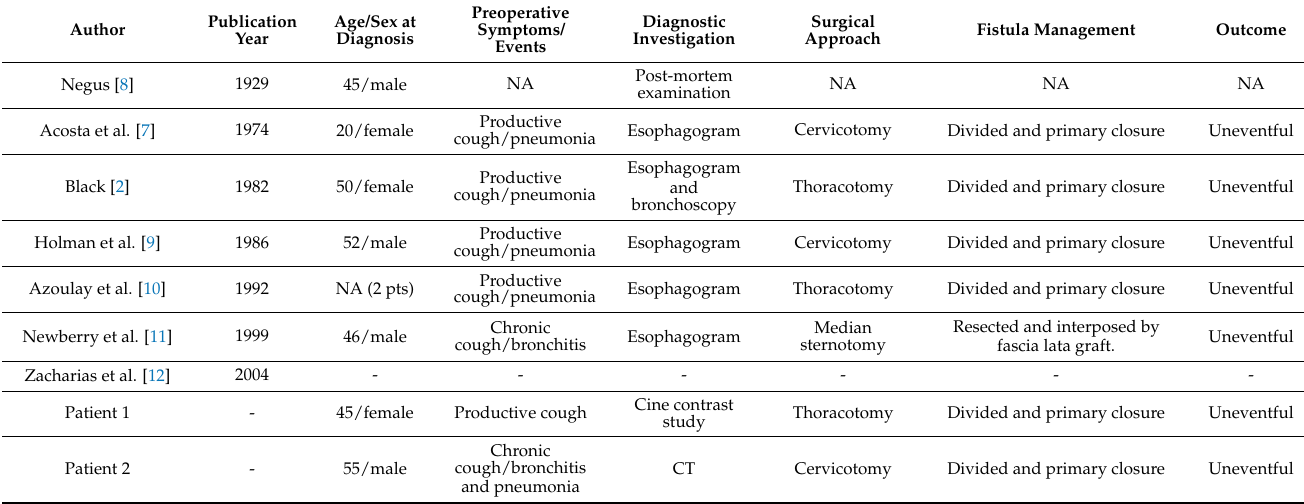
Table 1. Cases of adult-onset congenital H-type tracheoesophageal fistula in the